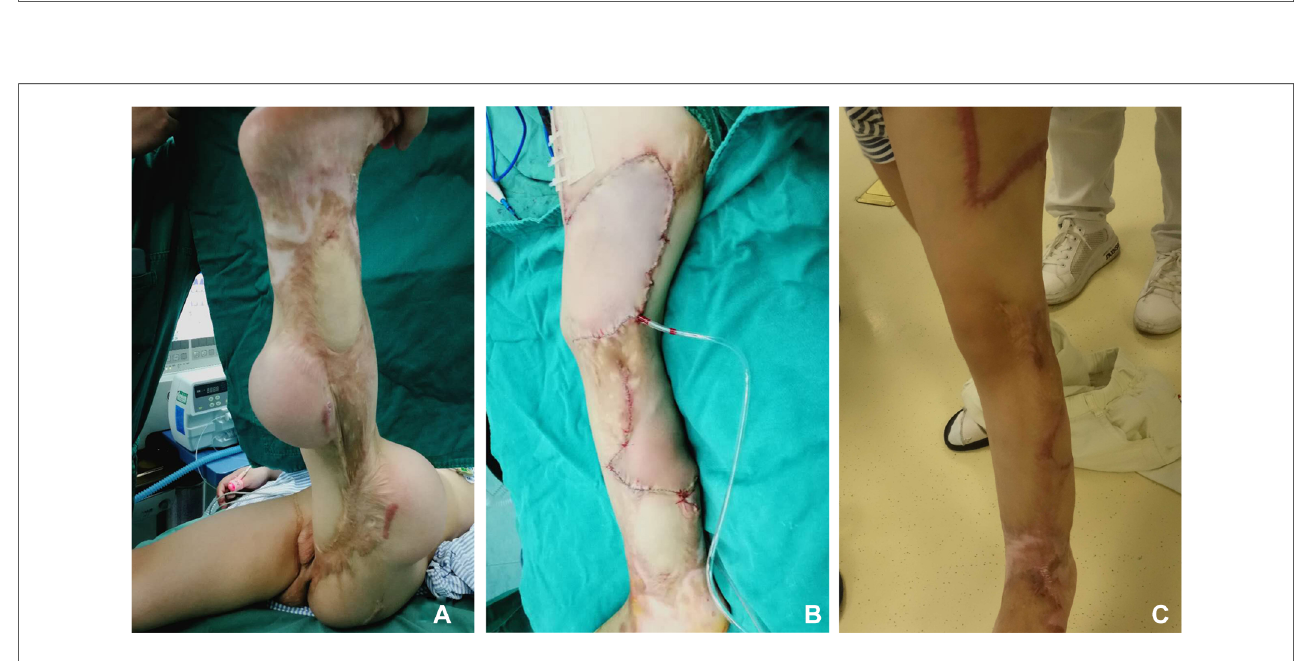
FIGURE 8 Case 3. ( A ) Preoperative appearance of the expanded fl ap. ( B ) Immediate postoperative appearance. ( C ) Postoperative appearance at